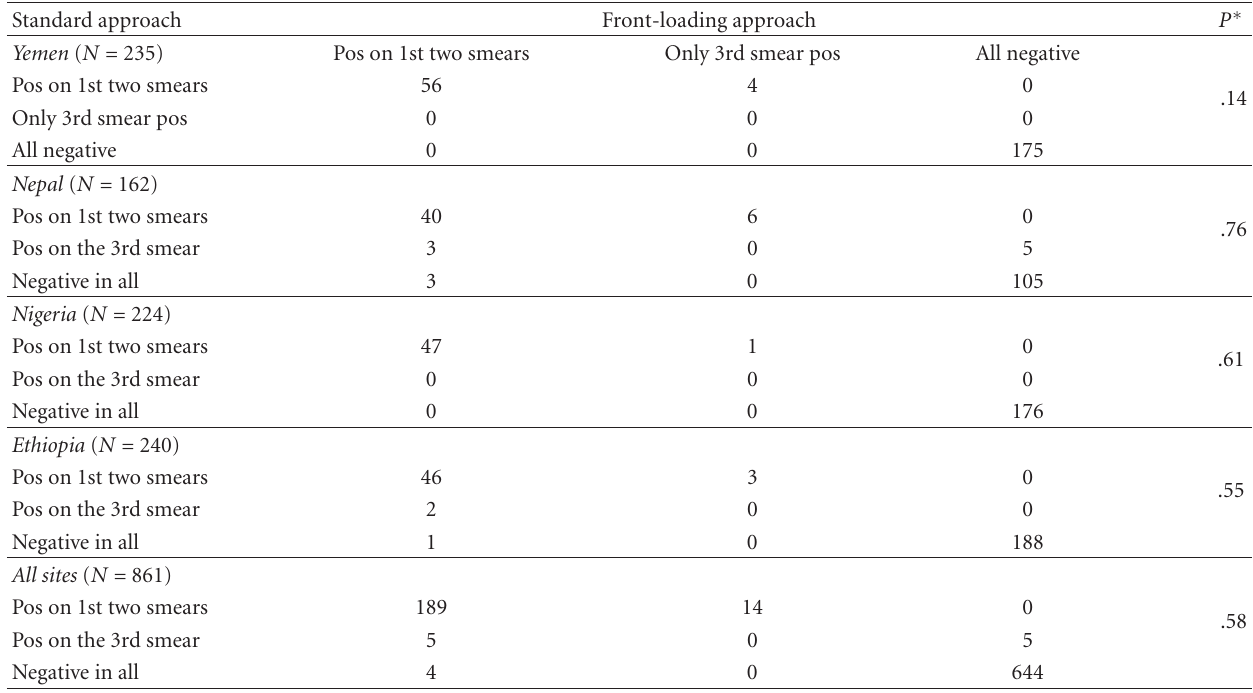
Table 2: Yield of the third smear for samples collected using the standard (spot-morning-spot) and the front-loading (spot-spot-morning) approaches by country. 62 patients (15 from Yemen, 44 from Nepal, and 3 from Ethiopia) were excluded as they did not submit the third specimen.